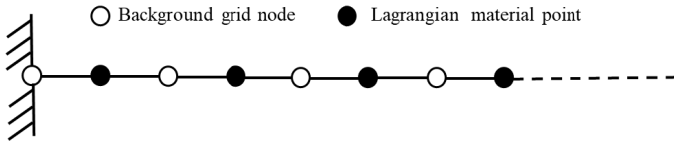
Figure 6. Flow chart of the analysis of MPM.